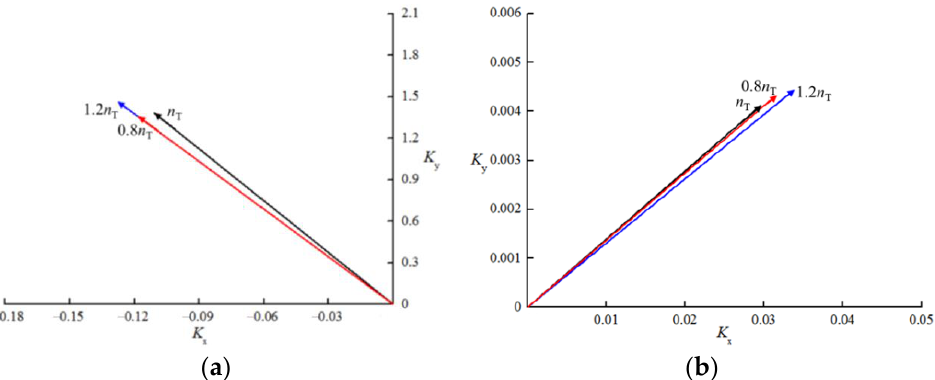
Figure 8. Initial direction and magnitude of radial hydraulic force: ( a ) On the volute; ( b ) On the impeller.